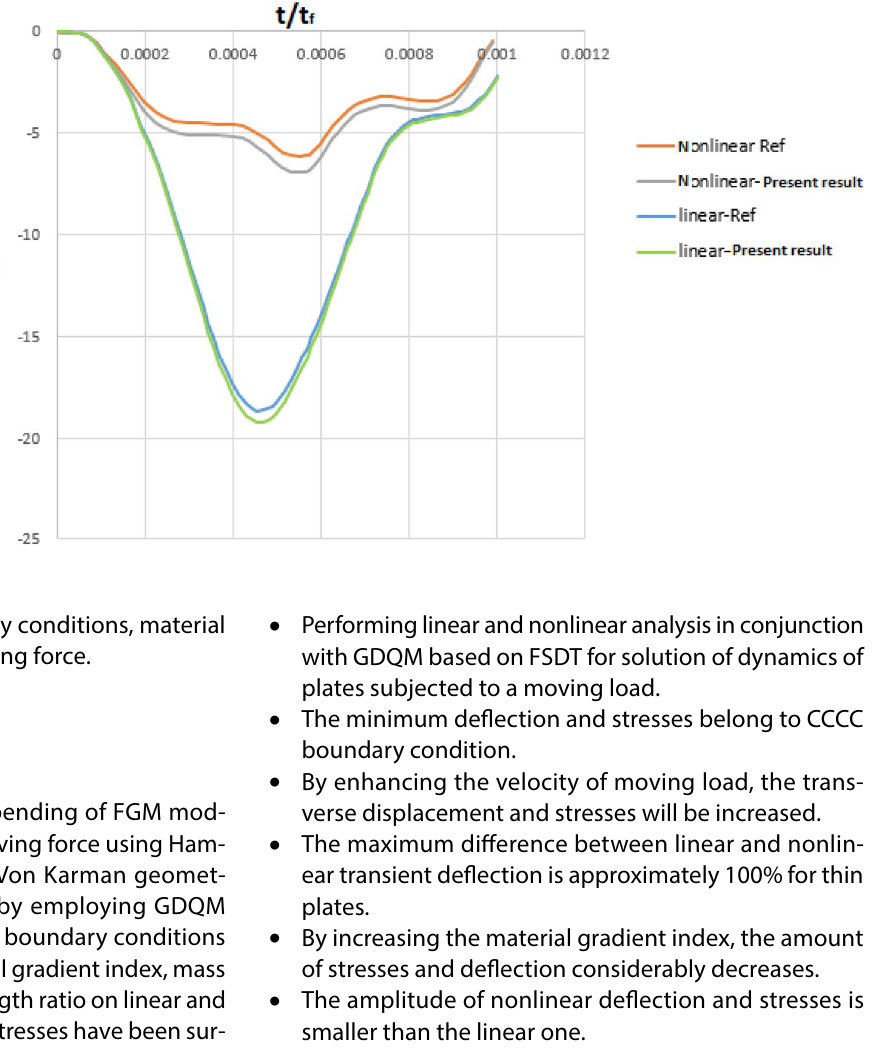
Fig. 5 Linear and nonlinear transient deflection of FGM simply supported plate com- pared with Ref